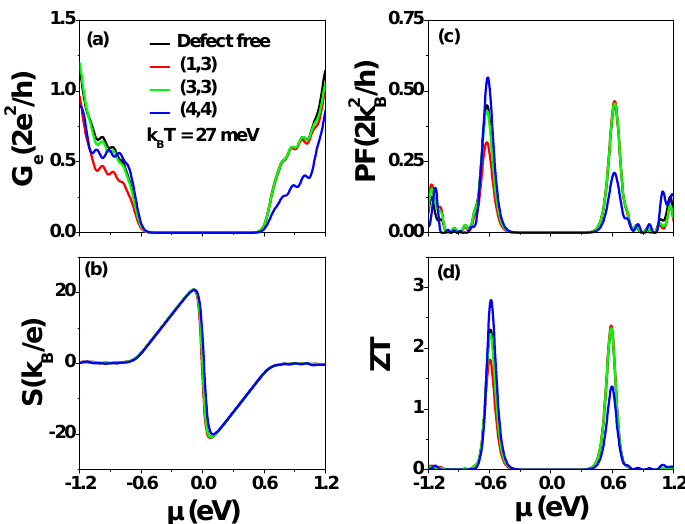
Figure 8. ( a ) Electrical conductance G e , ( b ) Seebeck coefficient S , ( c ) power factor PF , and ( d ) figure of merit ZT as functions of µ for different defect locations at k B T = 27 meV. Other physical parameters are the same as those of Figure 7. The phonon thermal conductance ( κ ph ) considered is the same as that used in Figure 5 ( κ ph = 0.0285